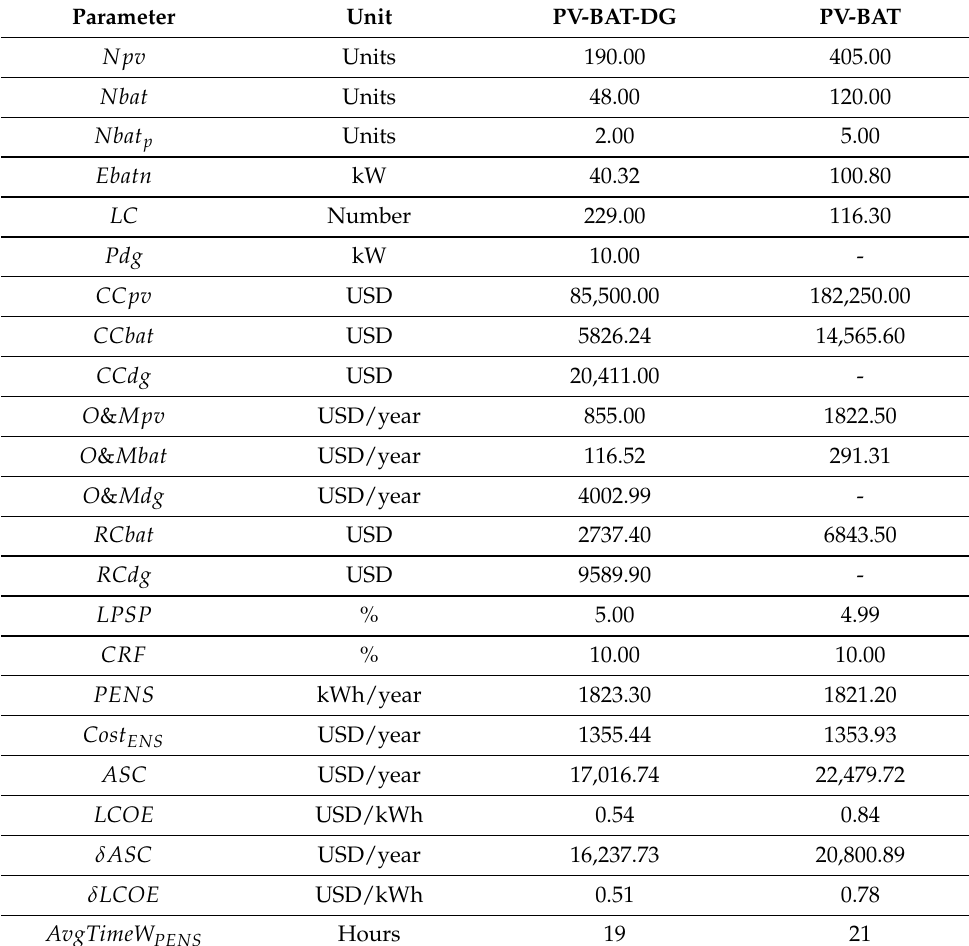
Table 5. Result of the study